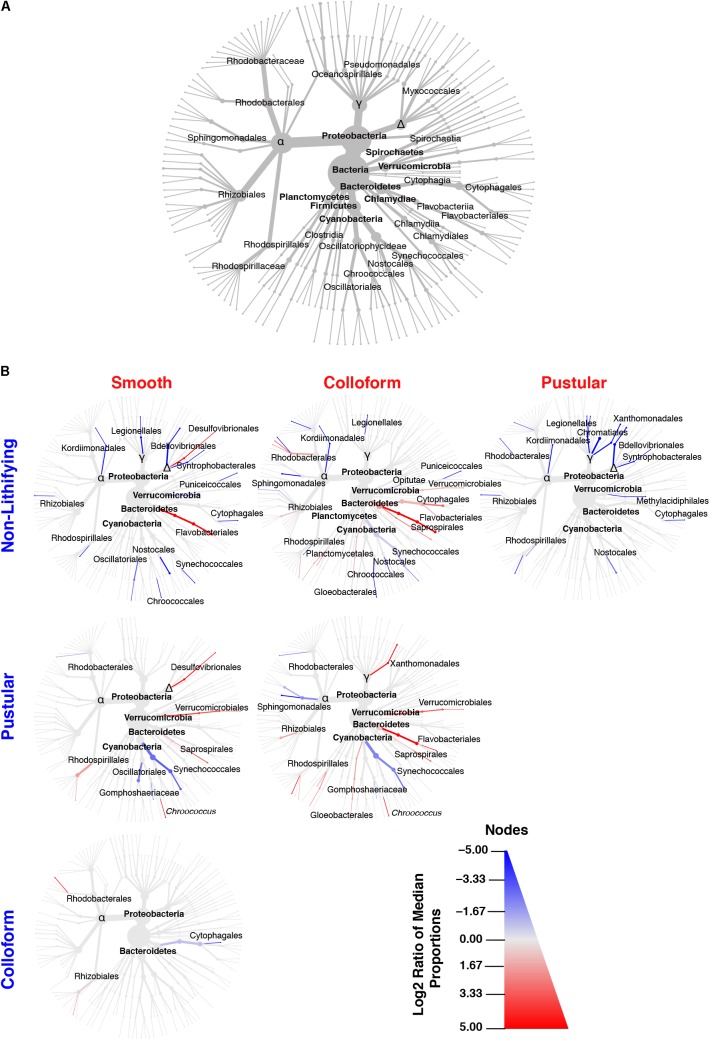
Taxonomic distribution of bacteria within the targeted mat types. (A) Overview of the top 35 bacterial taxa recovered from the 16 metagenomic libraries generated in this study and serves as orientation for (B). (B) Differential heat trees of pairwise comparisons between different mat types highlighting significant taxonomic enrichments (Wilcoxon test, p < 0.05). The color of each taxon represents the log-2 ratio of the median of the proportions observed with each mat type and corresponds to the different pairwise comparisons listed along the columns or rows. Node/edge color and size display the relative proportion for each taxon with lines in red reflecting those taxa enriched in mats along the x-axis and lines in blue enriched along the y-axis.